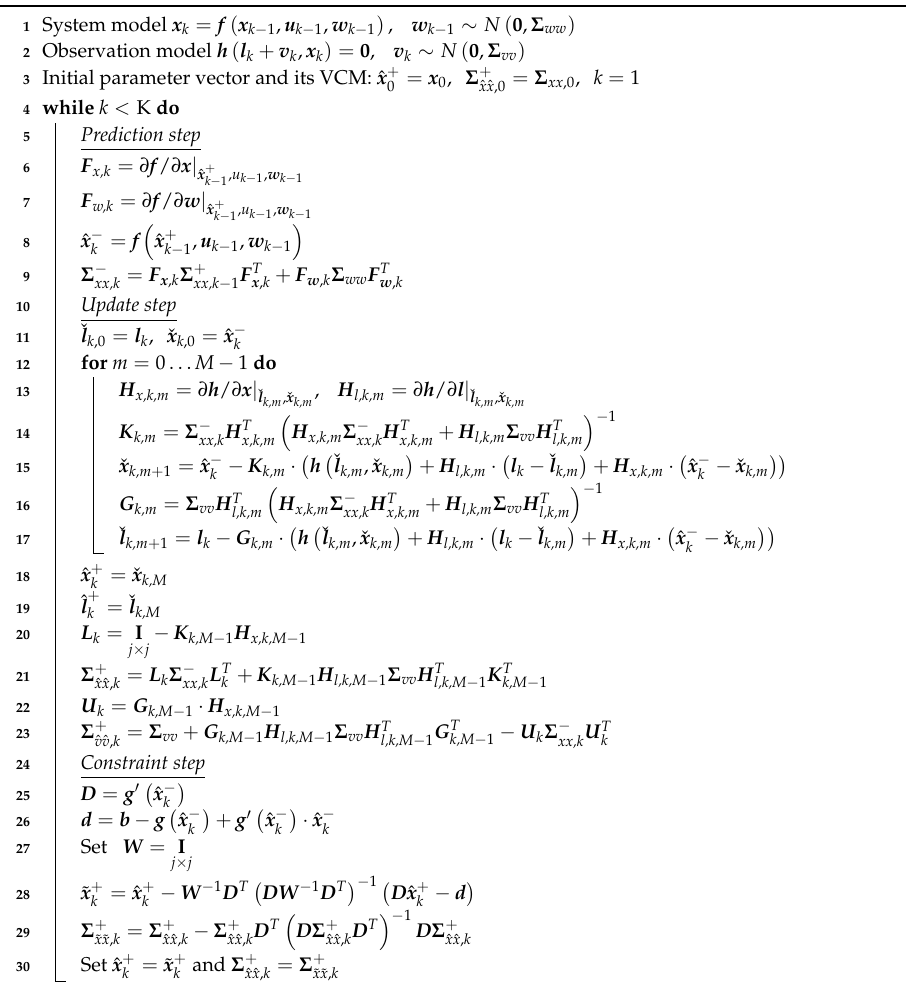
Algorithm 1: Iterated extended Kalman filter (IEKF) with nonlinear implicit measurement equation and nonlinear equality state